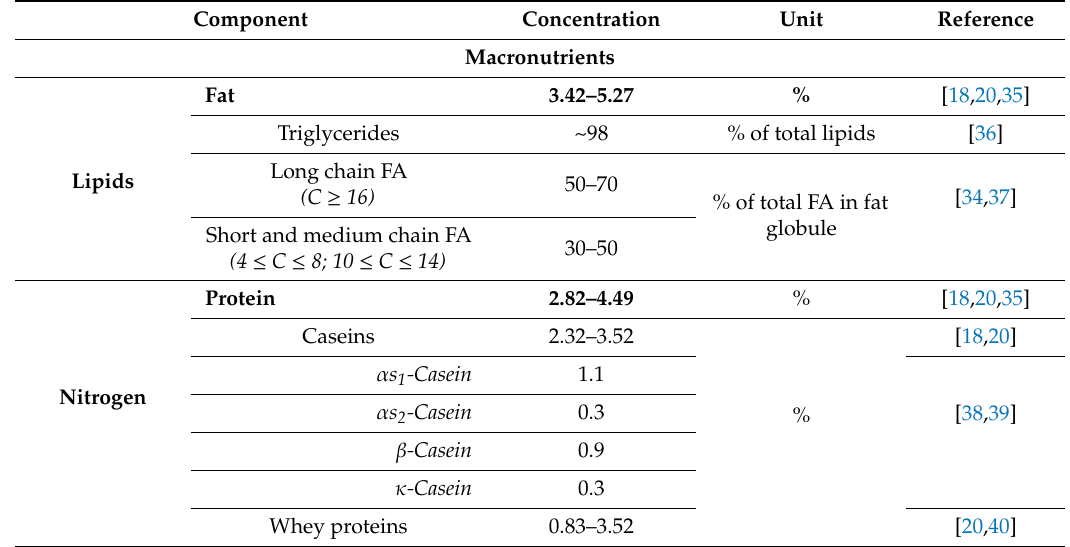
Table 1. Contents of macro and micronutrients in bovine